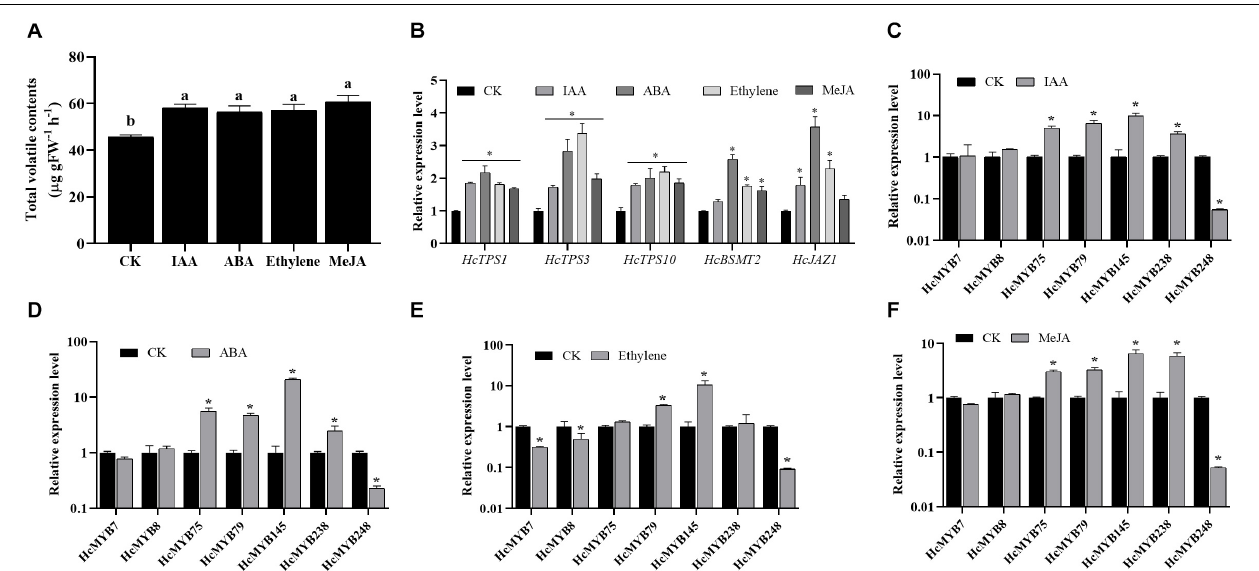
FIGURE 4 | Relative expression level of candidate HcMYB genes and emission of total floral volatiles under phytohormone stresses. (A) Total floral volatiles contents emitted during phytohormone treatments. (B) mRNA levels of key structural volatile biosynthesis genes upon phytohormone stresses. (C) IAA: (Inode-3-acetic acid), (D) ABA: (abscisic acid), (E) ethylene, (F) MeJA: jasmonic acid methyl ester. Error bars indicate SD of three biological replicates and asterisk represents significant differences ( ∗ p <